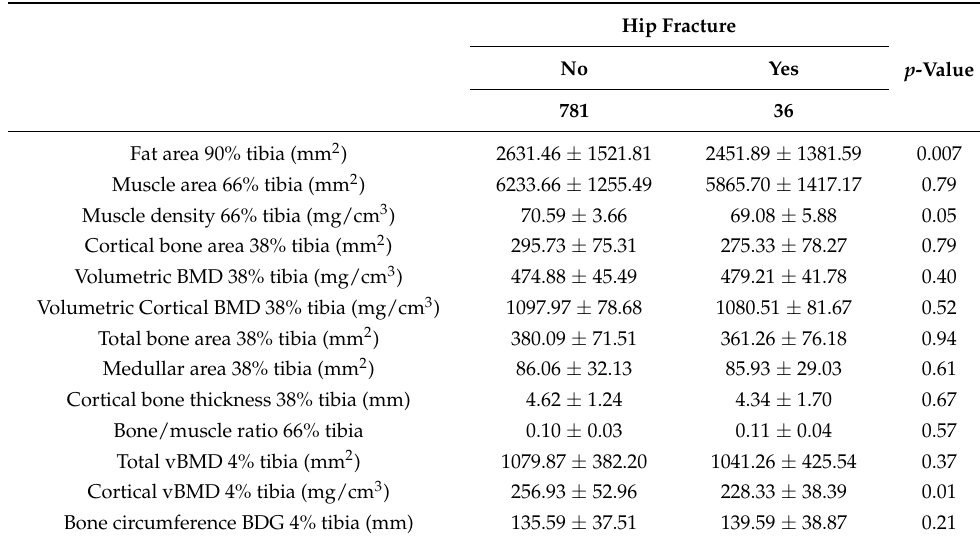
Table 2. Baseline pQCT results according to incident femur fractures. All p -values were age- and